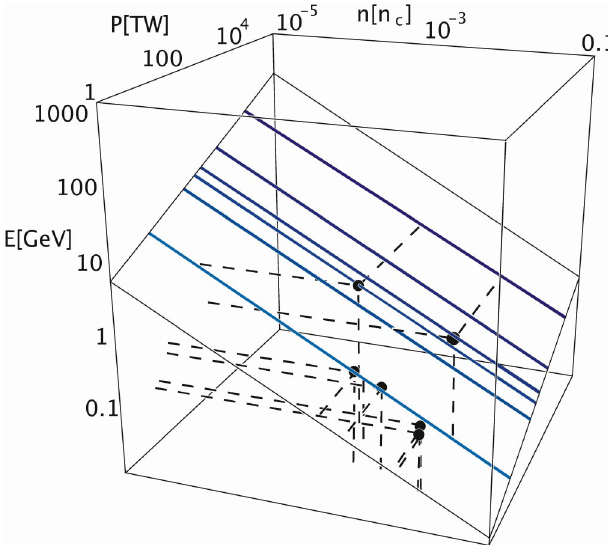
FIG. 5. (Color) E (cid:9) GeV (cid:10) vs power P (cid:9) TW (cid:10) and density n=n Eq. (6): The blue lines of constant power show the strong dependence of the energy of the self-trapped electrons to the density. The black points correspond to (a) experiment [10], (b) experiment [11] which uses a channel for guiding, (c) ex- periment and 3D PIC simulation [12], (d) 3D PIC simulation [7] which uses a channel for guiding, (e) A 3D PIC simulation in [6], and (f) 3D PIC simulation presented in this article. Each of these points is very close to 1 of the blue lines indicating agreement with our scaling law.